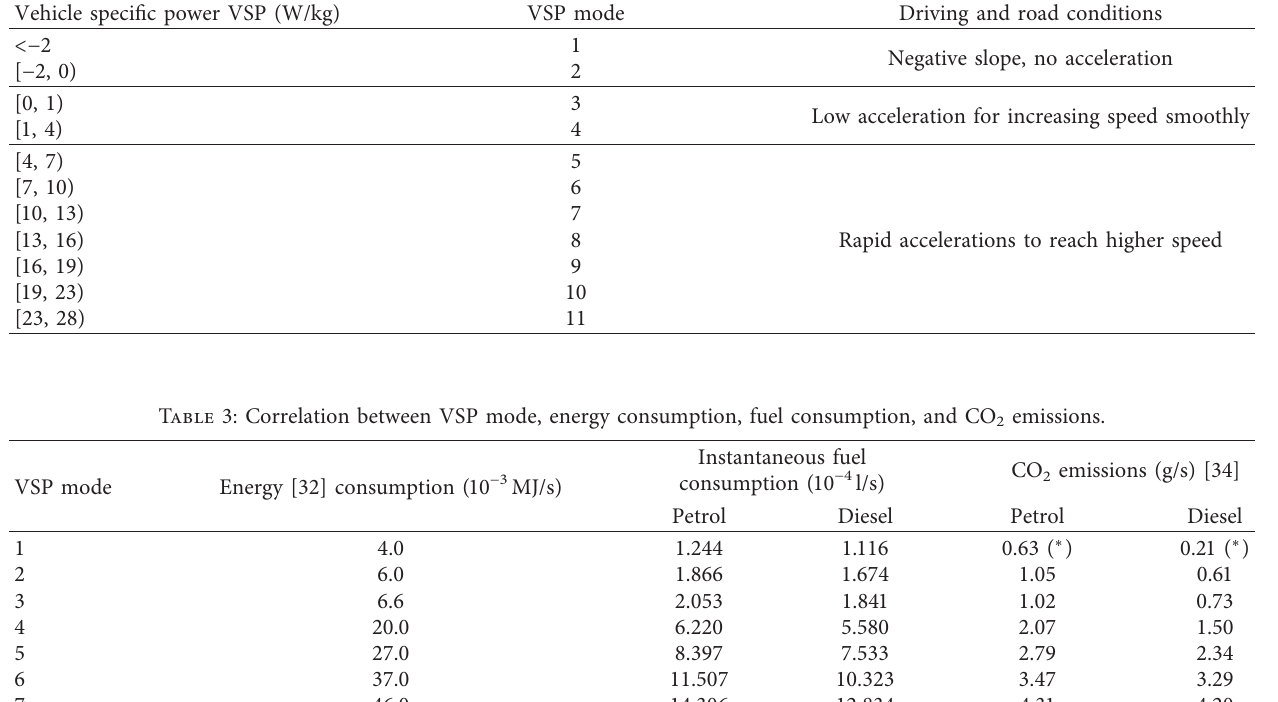
Table 2: Correlation between VSP (power requirements in W/Kg) and “VSP mode.”